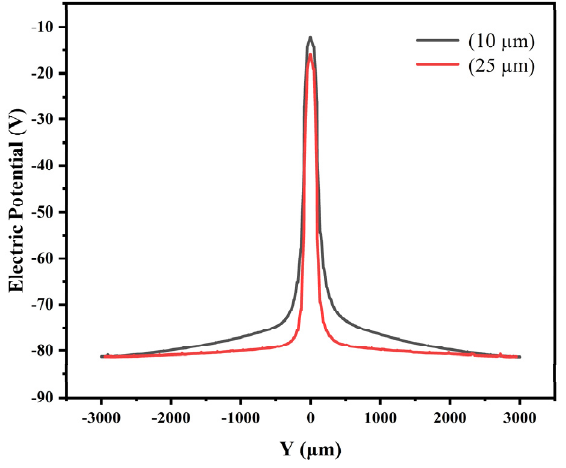
Figure 6. Distribution of potential in one-dimensional section of SDD (Z = 30 µ m).